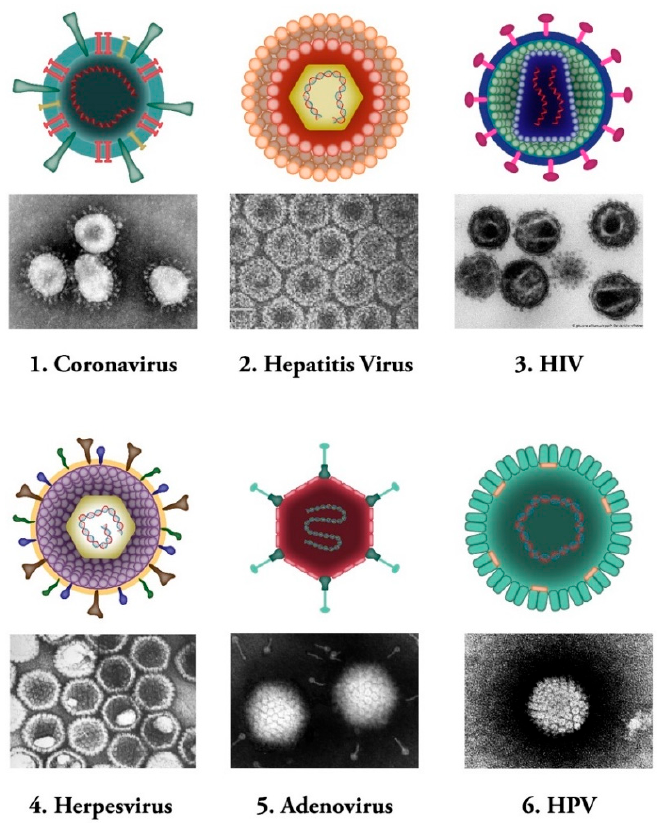
Figure 1. Common human viral pathogens. Six types of human infecting viruses, including corona- virus, hepatitis virus, human immunodeficiency virus (HIV), herpesvirus, adenovirus, human pap- illoma virus (HPV) are depicted schematically or as observed under electron microscopes.